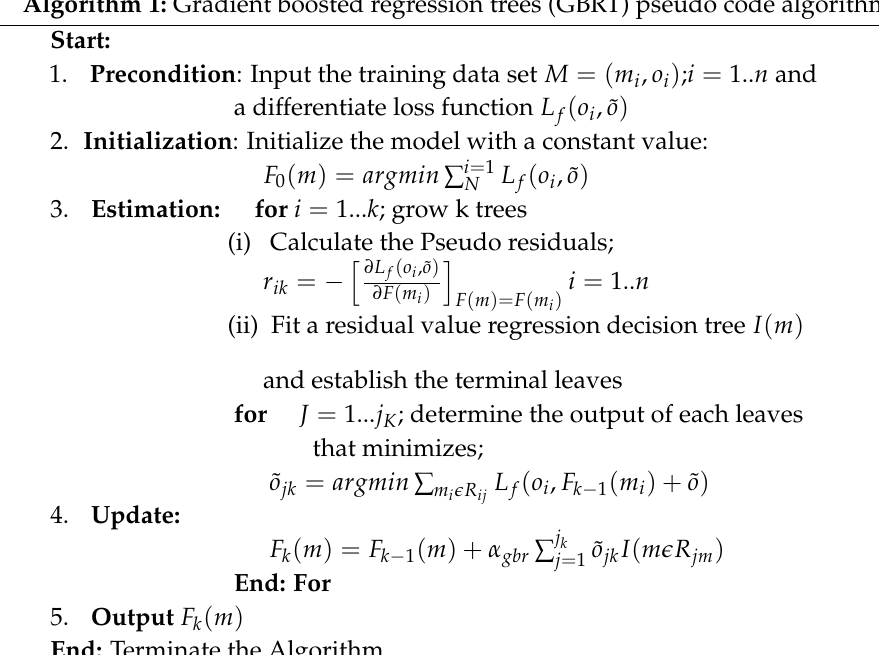
Algorithm 1: Gradient boosted regression trees (GBRT) pseudo code